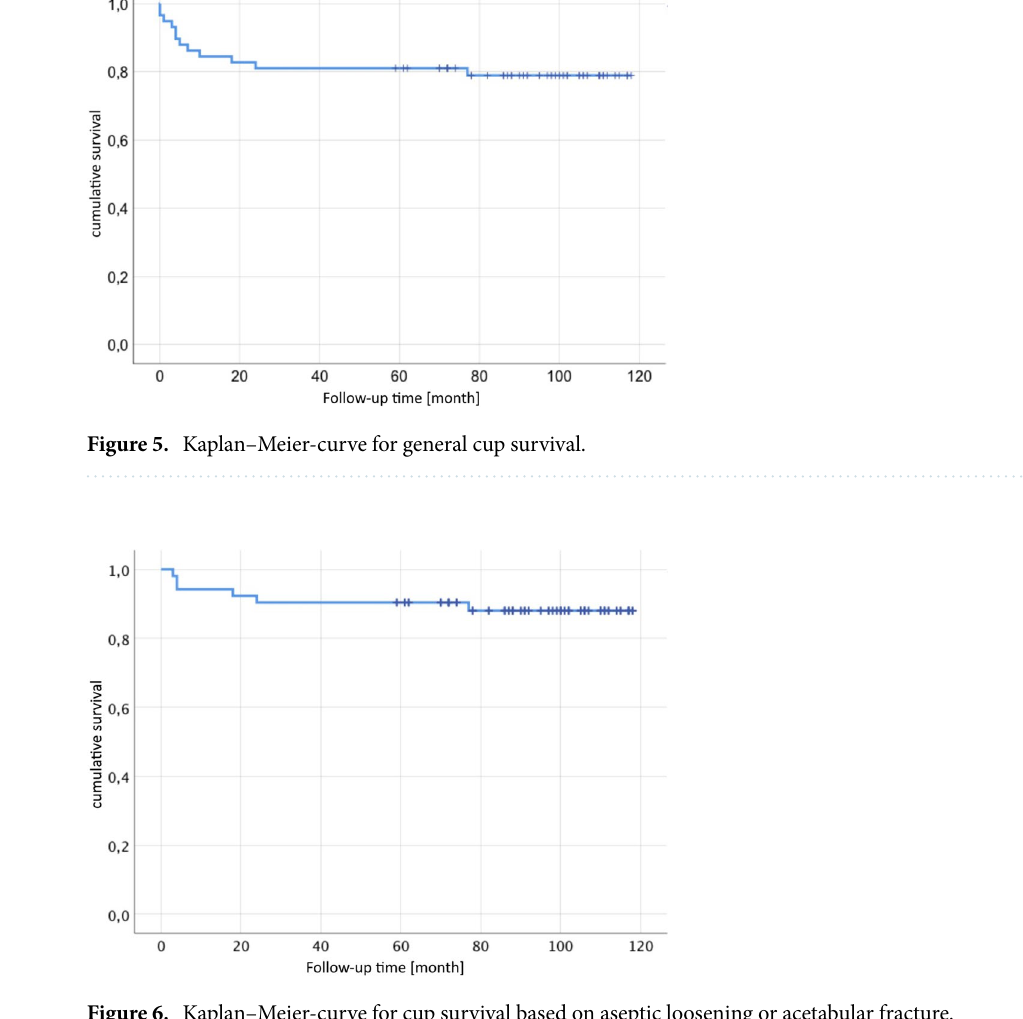
Figure 6. Kaplan–Meier-curve for cup survival based on aseptic loosening or acetabular